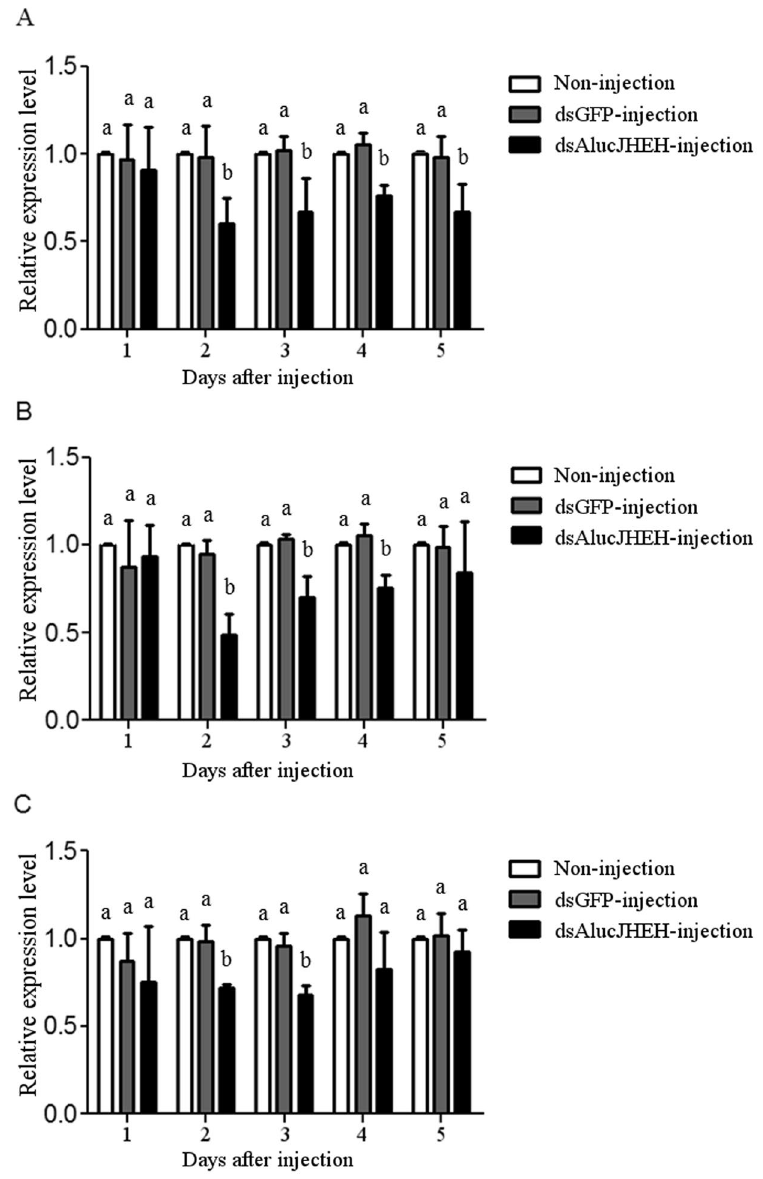
Figure 6. The relative expression levels of AlucJHEH gene in Apolygus lucorum after injection of different ds AlucJHEH fragments. ( A ) Injection of ds AlucJHEH -F1. ( B ) Injection of ds AlucJHEH -F2. ( C ) Injection of ds AlucJHEH -F3. The results are shown as the Mean ± S.E. There is no significant difference ( P ≤ 0.05) in the levels of AlucJHEH gene expression among the samples with the same alphabetic